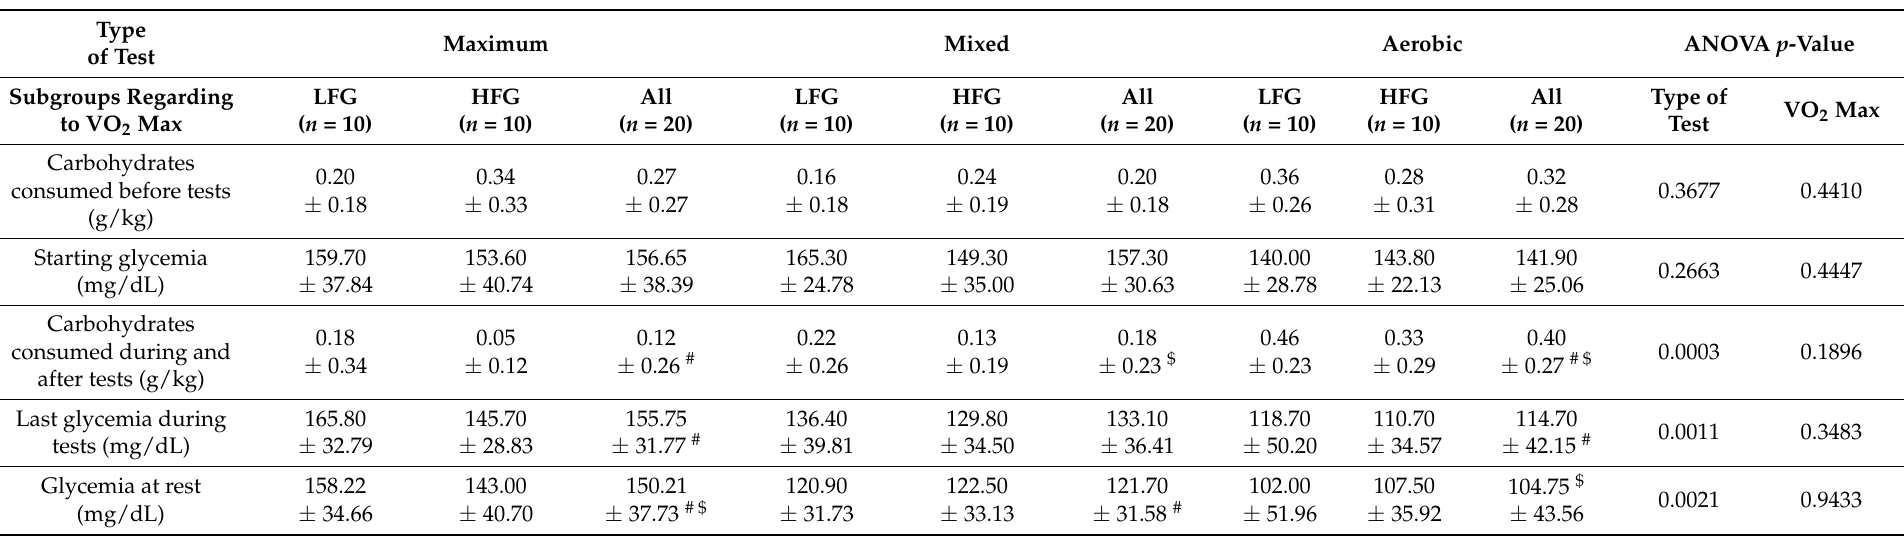
Table 2. Comparison of glucose levels and consumed carbohydrates during each